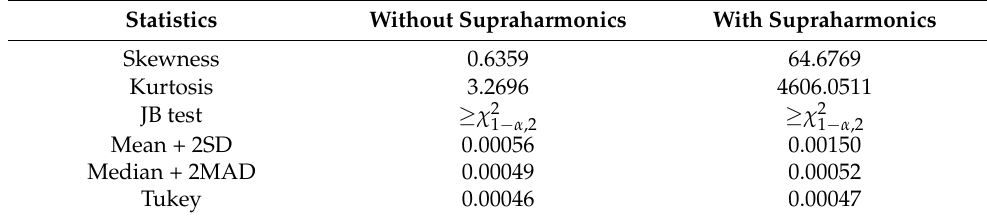
Table 2. Signal statistics calculation